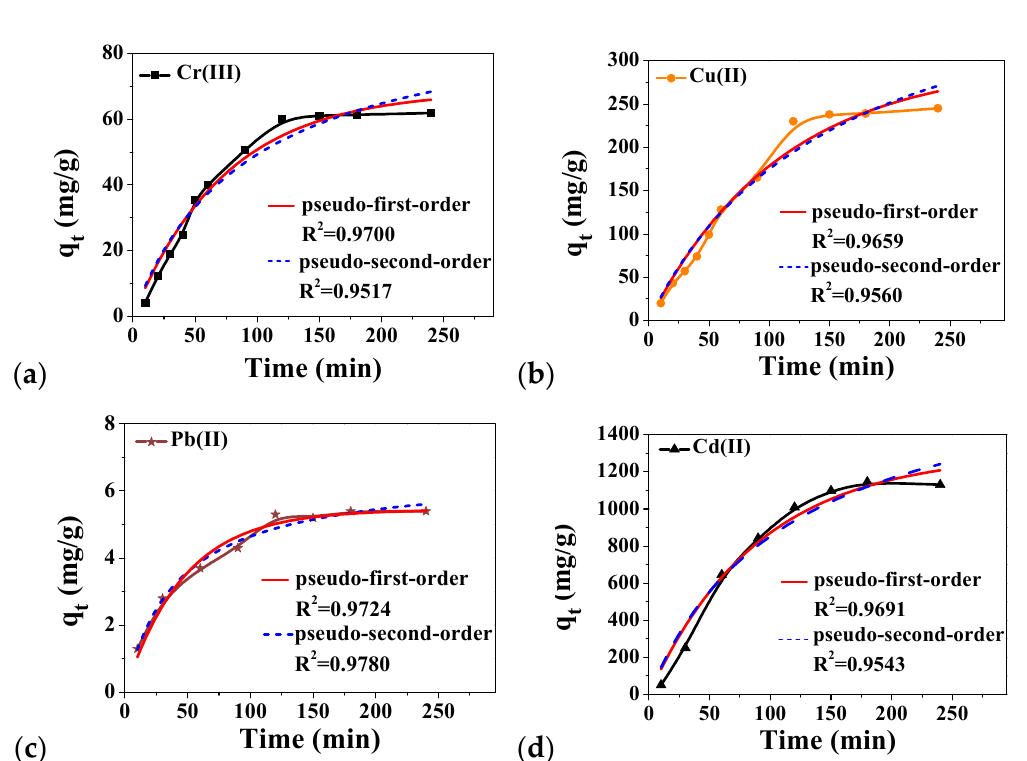
Figure 4. ( a – d ) Adsorption kinetic curves of four metal ions by Fe 3 O 4 @Me 6 TREN NPs: ( a ) Cr(III); ( b ) Cu(II); ( c ) Pb(II); ( d ) Cd(II). Table 1. Adsorption kinetic parameters of the Fe 3 O 4 @Me 6 TREN NPs for Cr(III), Cu(II), Pb(II), and Cd(II) ions.